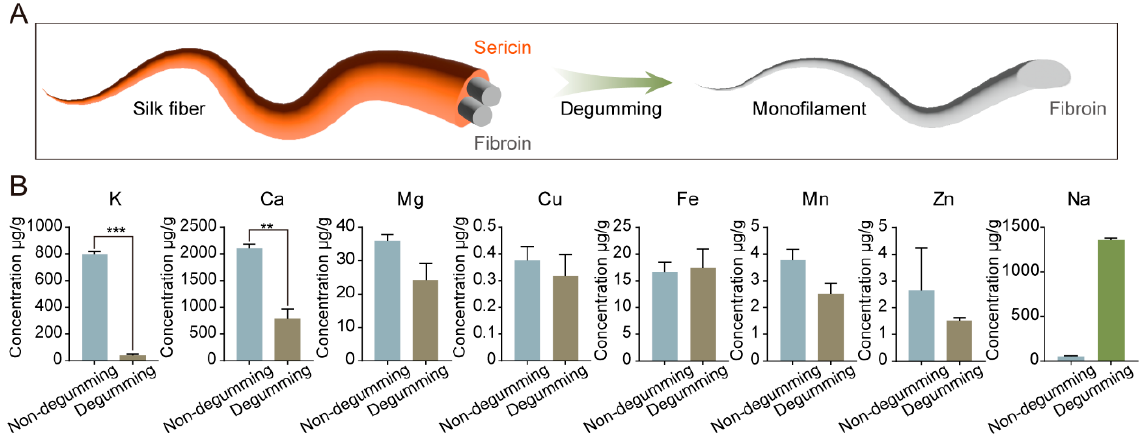
Figure 5. Content of metallic elements in non-degummed and fully degummed silkworm